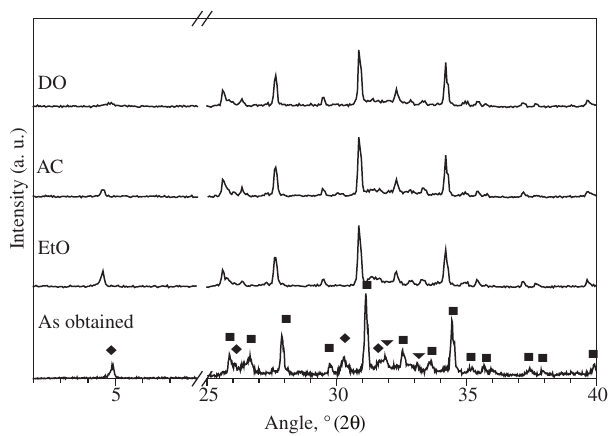
Figure 1. X Ray diffraction patterns before and after sterilization.  ) β -TCP;  ) CDHA; and  )